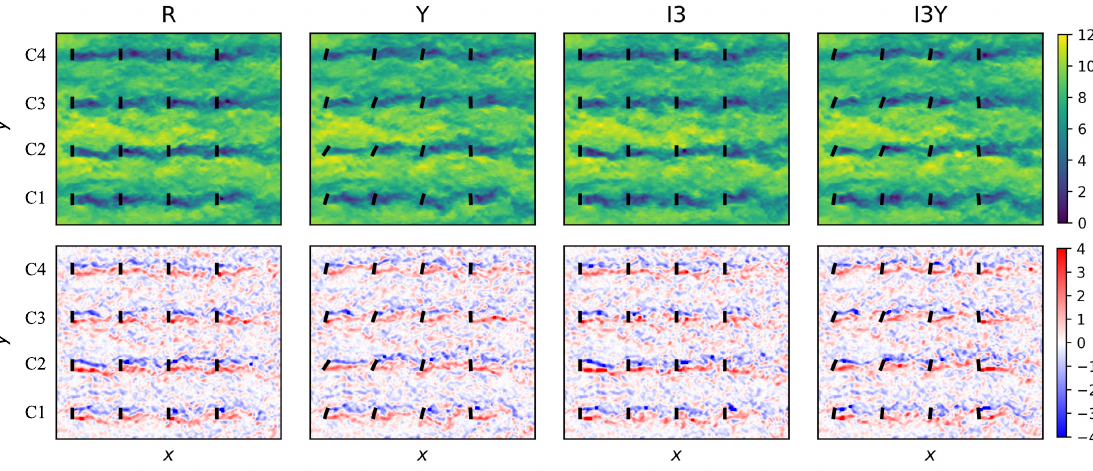
Figure 11. Instantaneous planviews at hub height for turbulent inflow cases at t = 300 s. Top: Streamwise velocity. Coloring in m s − 1 . Bottom: Wall-normal vorticity. Coloring in s − 1